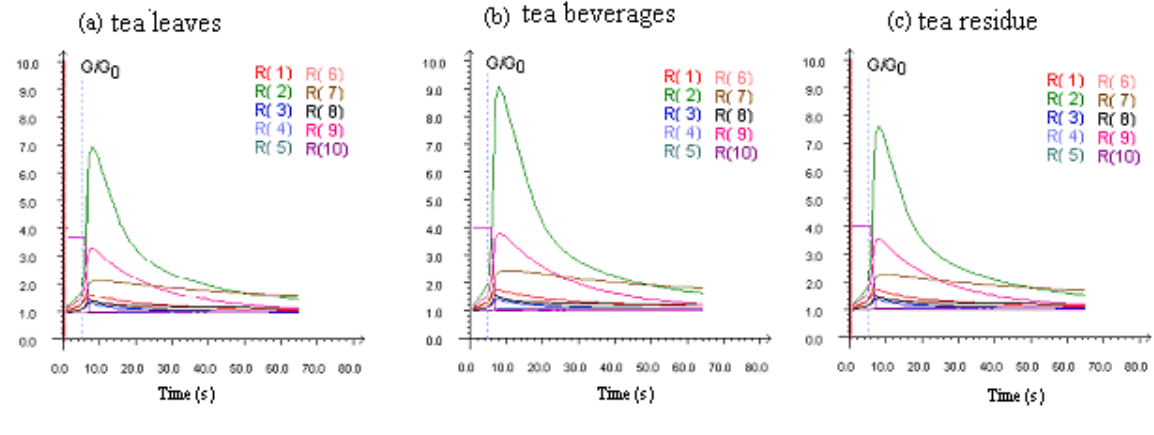
Figure 1. The response curve of tea leaves, tea brew and tea